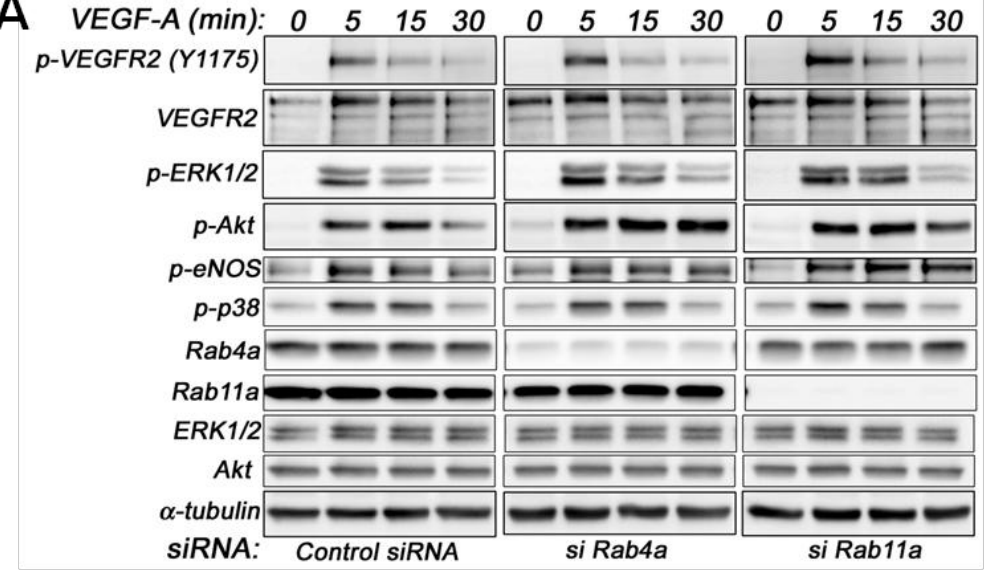
Figure 6. Effects of Rab silencing on VEGF-A-stimulated intracellular signalling in endothelial cells. ( A ) HUVECs were subjected to RNAi (see Materials and Methods) and the control; Rab4a- or Rab11a-depleted HUVECs were then stimulated with VEGF-A followed by quantitative immunoblotting for ( B ) VEGFR2-pY1175, ( C ) phosphorylated Akt (p-Akt S473), ( D ) phosphorylated MAPK (p42/44 MAPK or p-ERK1/2 T202/Y204) and ( E ) phosphorylated eNOS (p-eNOS S1179). The data shown are derived from the analysis of three or more independent experiments. Error bars denote ±SEM, with asterisks indicating significance ( * , p <